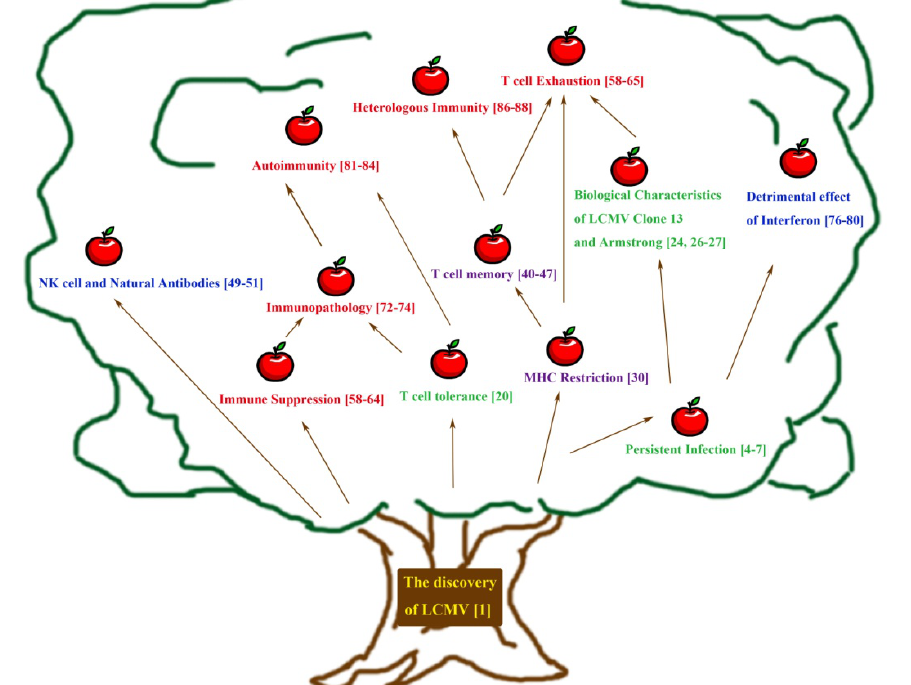
Figure 1. Tree of knowledge as disseminated by the lymphocytic choriomeningitis virus (LCMV) model system. This tree depicts a partial history of significant research milestones with the LCMV model system. The conceptual and/or experimental relationship between different discoveries is represented by uni-directional arrows. Green font is used to represent the first part of this review, concepts in persistent viral infection. Purple is used to highlight the second section, T cell immunity. Blue is used to represent the third section, innate immunity. Lastly, red represents the fourth and final section of immune dysfunction. Of note, certain scientific ideas (e.g., “T cell exhaustion”) are conceptually and experimentally derived from multiple lines of research and thus relevant to multiple sections of this review and our understanding of viral immunology. However, for simplicity they are represented by a single